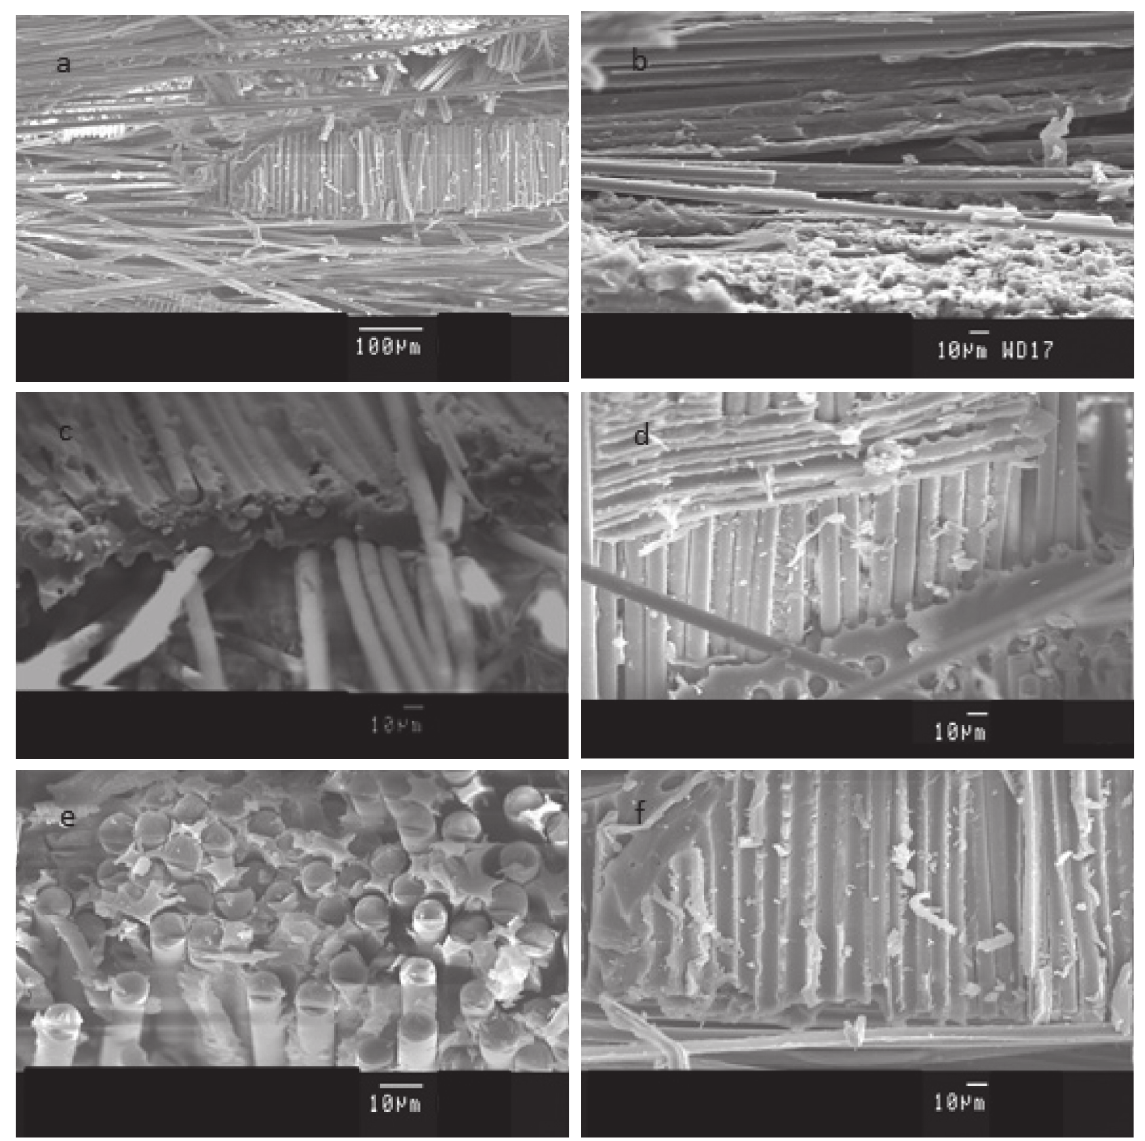
Figure 8: Fracture surface of the (a) glass/vinyl ester composite, (b) 2% CB reinforced, (c) 3% CB reinforced, (d) 4% CB reinforced, and (e) and (f) 5% CB reinforced glass/vinyl ester